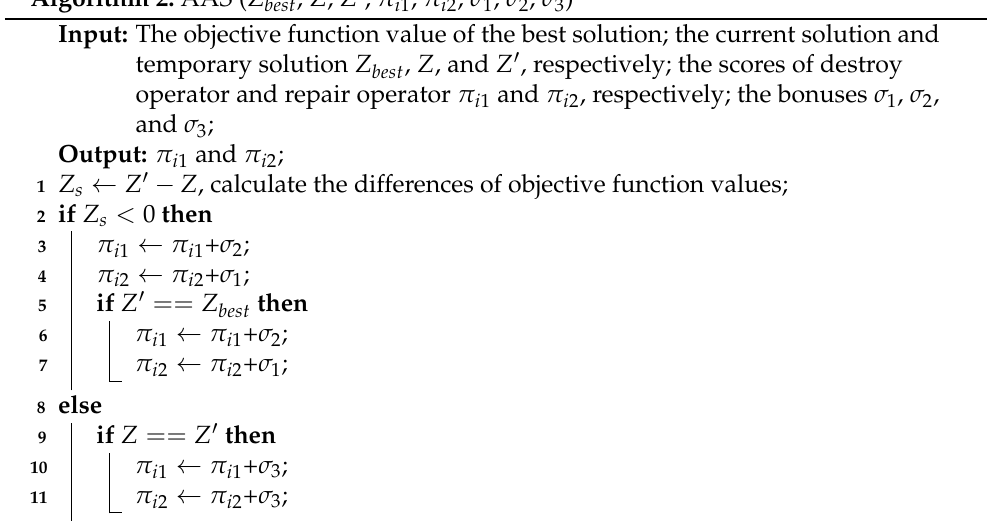
Algorithm 2: AAS ( Z best , Z , Z (cid:48) , π i 1 , π i 2 , σ 1 , σ 2 , σ 3